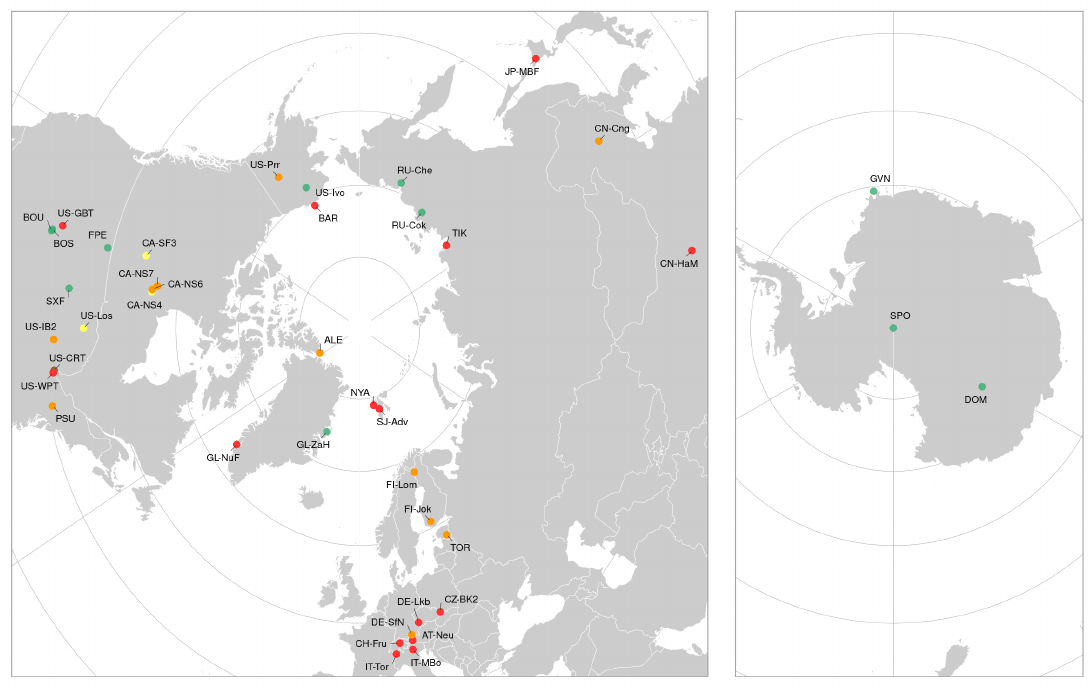
Figure 1. Location of the stations used in the study. Stations used in the point-to-pixel comparison are in green. Stations discarded are in red (low snow representativeness), orange (low land cover homo- geneity), yellow (low albedo representativeness) and brown (no fully snow-covered measurements). Three letter codes (SSS) indicate BSRN a station. NN-SSS indicates FLUXNET